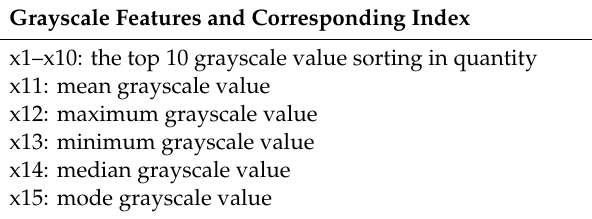
Figure 4. Vitrinite images with different MMVR and the corresponding grayscale probability density distribution (from left to right, the MMVR is 0.7%, 0.88%, 1.16%, and 1.79%, respectively. The second row shows the grayscale probability density distribution of the corresponding images). ( a ) Vitrinite images; ( b ) Grayscale probability density distribution. Table 1. Grayscale feature space utilized in regression procedure. Table 1. Grayscale feature space utilized in regression procedure.